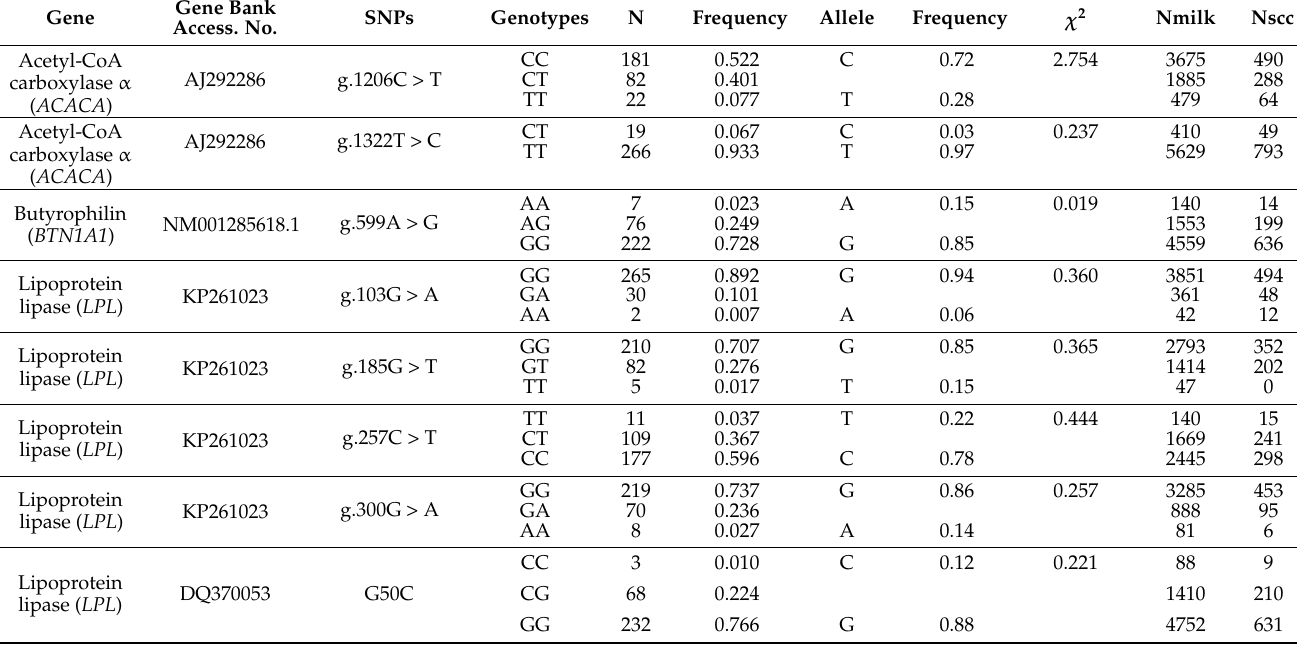
Table 2. Genotype and allelic frequencies and the number of animals and records included in the analysis. Gene Gene Bank Access.